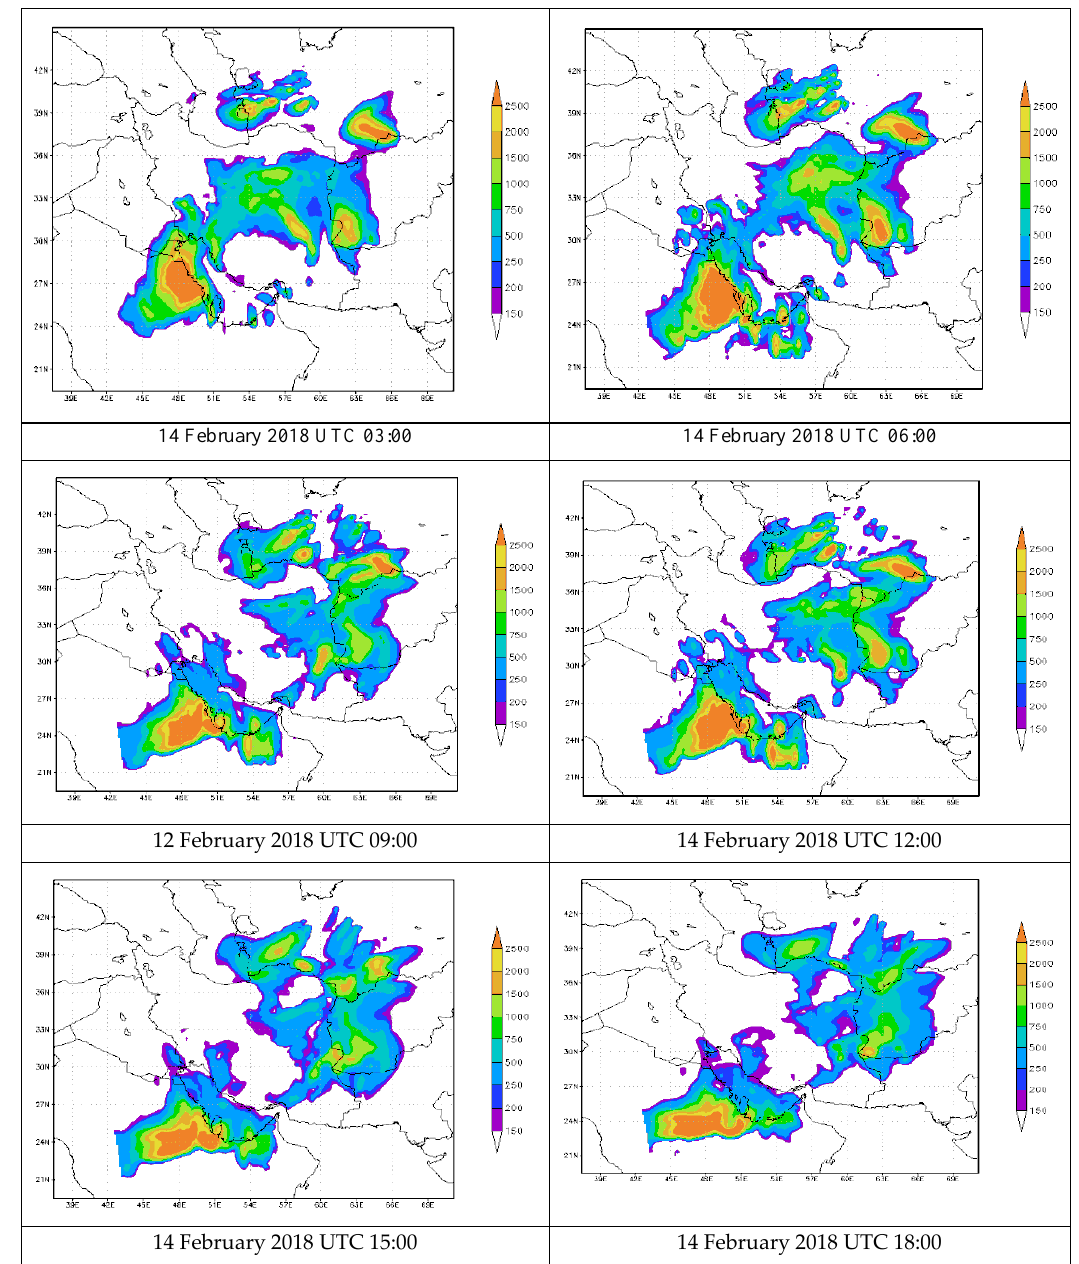
Figure 16. Spatial pattern of dust surface concentration (µg/m 3 ) with the AFWA scheme in 14 February 2018.